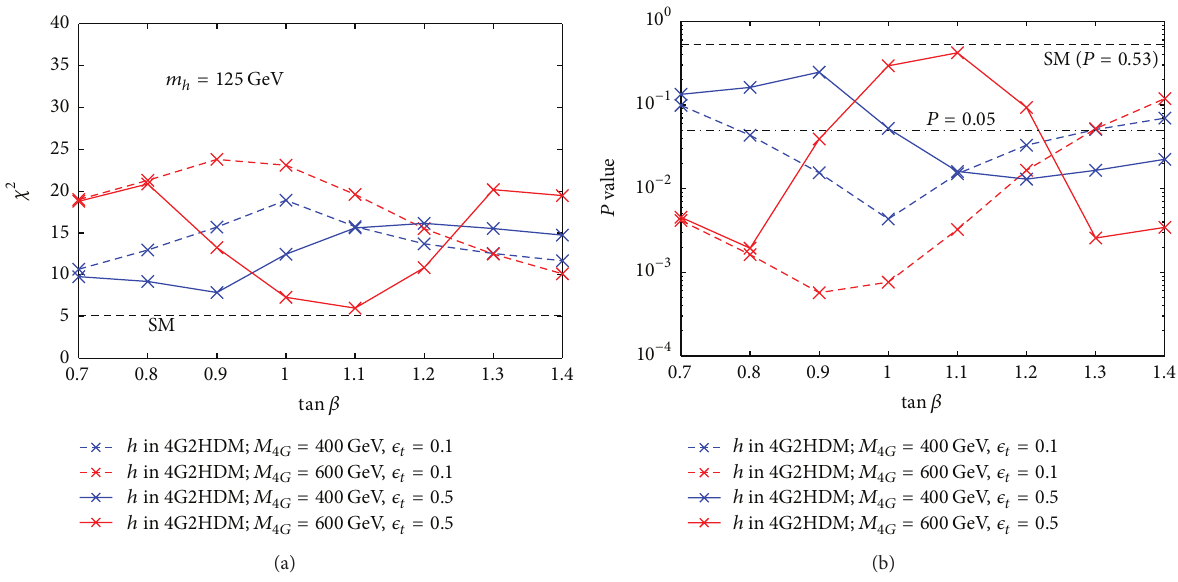
Figure 23: 𝜒 2 (a) and 𝑃 values (b), as a function of tan 𝛽 , for the lightest 4G2HDMI CP-even scalar ℎ , with 𝑚 ℎ = 125 GeV, 𝜖 𝑡 = 0.1 and 0.5 , = 𝑚 = 400 and 600 GeV. The value of the Higgs mixing angle 𝛼 is the one which minimizes 𝜒 2 for each value and 𝑀 4𝐺 ≡ 𝑚 𝑡 󸀠 = 𝑚 𝑏 󸀠 = 𝑚 𝑙 ] 4 4 of tan 𝛽 . The SM best fit is shown by the horizontal dashed line and the dash-dotted line in the right plot corresponds to 𝑃 = 0.05 and serves as a reference line. Figure taken from